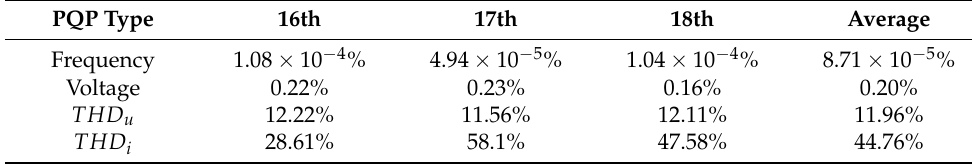
Table 9. Forecasting error (MAPE in%) for 16–18 August 2021, when using QLR.